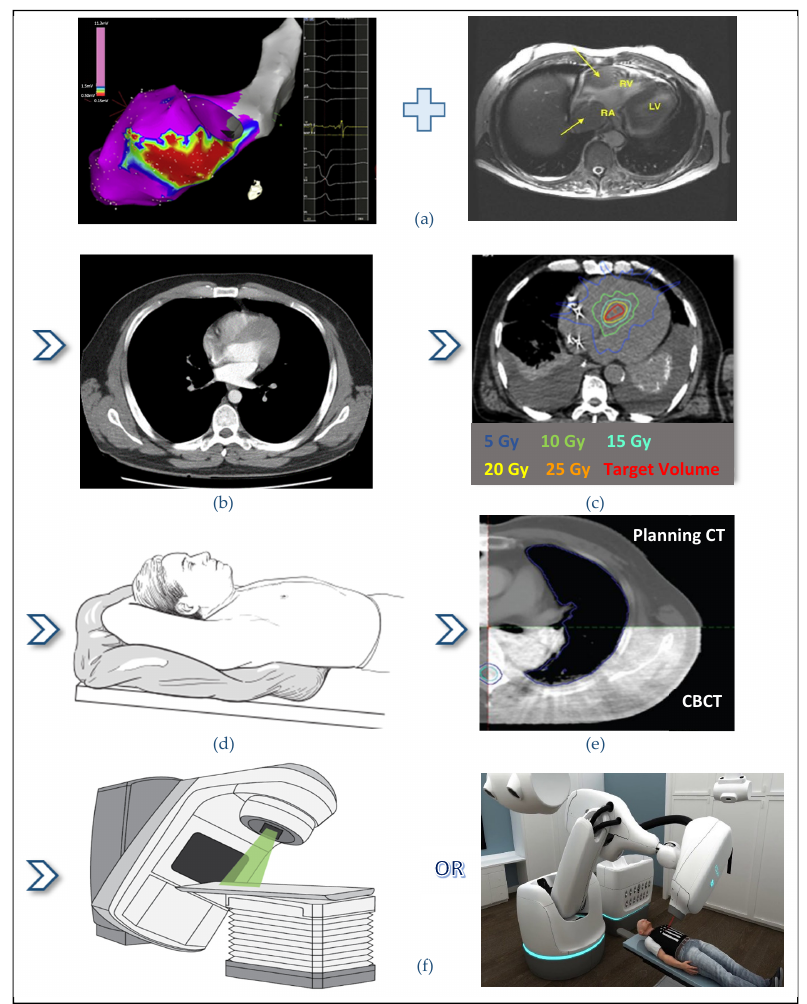
Figure 4. Stereotactic Arrhythmia Radioablation (STAR) workflow: ( a ) Three-dimensional view of the target volume (red) and the surrounding tissues. The electrophysiology information fused with anatomical imaging leads to the target volume generation; ( b ) Planning Computed Tomography (CT) at the CT-simulator; ( c ) Radiotherapy plan showing the target volume and isodose lines. In this example, a dose of 25 Gy in a single fraction is prescribed for delivery to the target volume; ( d ) Patient is positioned and immobilized with the use of a vacuum-assisted device; ( e ) By means of an image-guided, radiotherapy-equipped linear accelerator, a cone-beam CT is used to align the simulation target with the treatment target volume; ( f ) Finally, treatment is delivered with the use of the radiotherapy delivery system. A Linac system on the left and a CyberKnife system on the right are